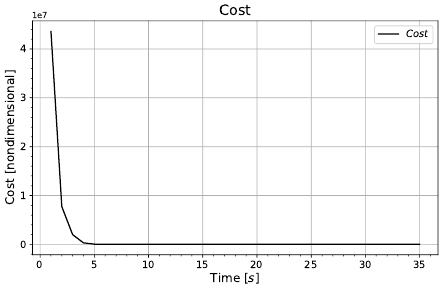
Figure 6. The second time derivatives ( a ) and phase trajectory tracking ( b ) for q 3 .